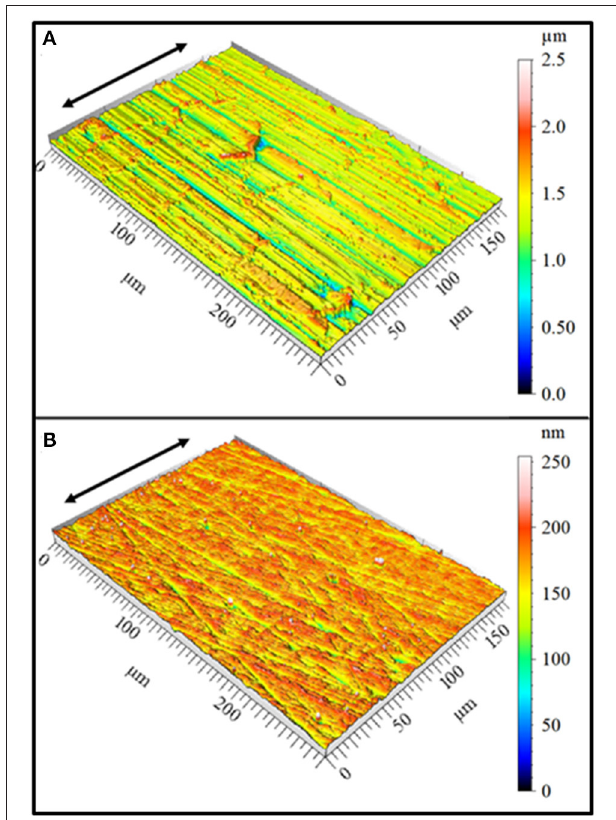
FIGURE 8 | Topography before tribological tests. (A) Cylinder. (B) Coated piston.